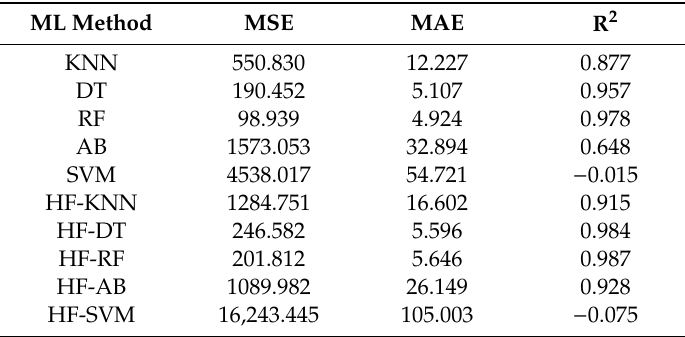
Table 11. Latitude regression results of testing